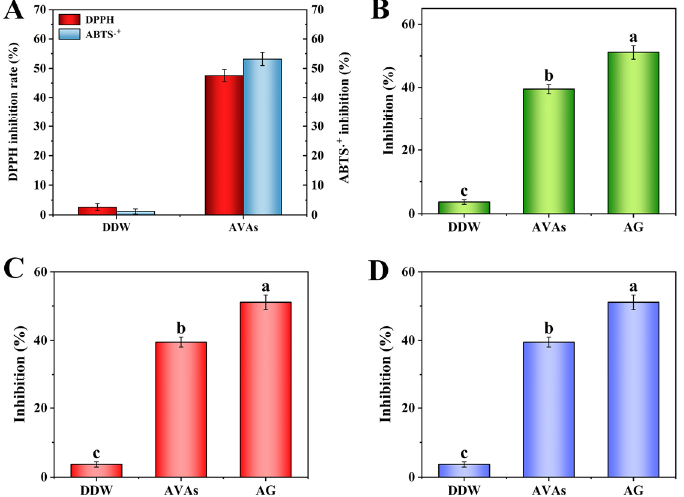
Figure 2. ( A ) Antioxidant results of the oat extract-derived AVAs. Inhibitory rates of oat-extracted AVAs on ( B ) CML, ( C ) CEL, and ( D ) PRL. Letters above the columns represent significant difference at p < 0.05.